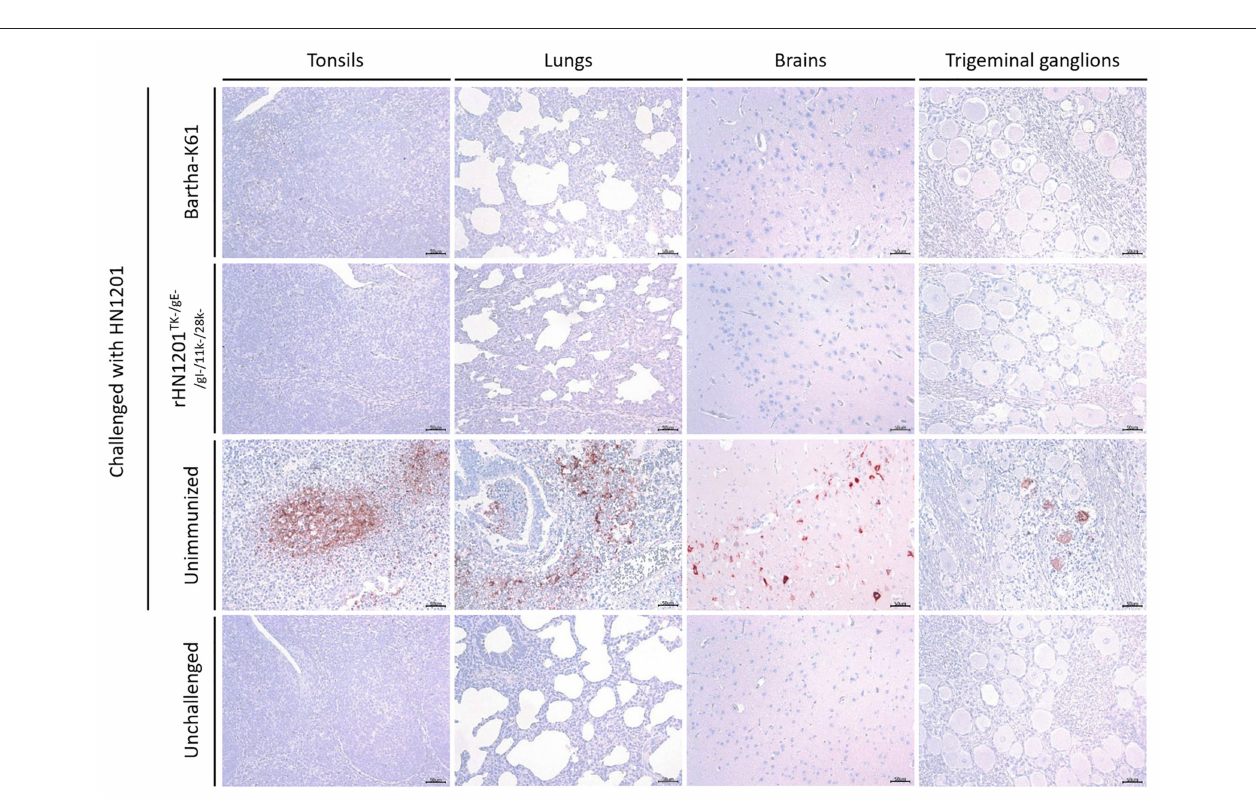
FIGURE 5 | Results of IHC assay of tonsils, lungs, brains, and trigeminal ganglions. Representative IHC images of tonsils, lungs, brains, and trigeminal ganglions were shown corresponding to animal groups infected with HN1201. The groups’ names were indicated on the left of the figure. Bar = 50 µ m. (35), which was consistent with the findings in our study. An attenuated PRV strain with the deletion of US8/11k/28k genes results in a higher titer and larger plaque size than that of WT treatment in Vero cells (36), while the larger size of the plaque formed by JS-2012 was considered induced by the cell adaption in Vero cells (120